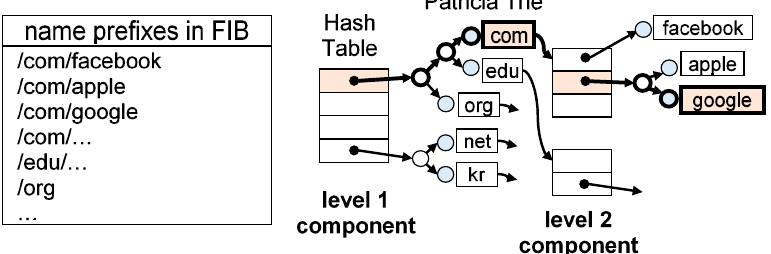
Figure 4. Proposed structure of the forwarding information base (FIB).